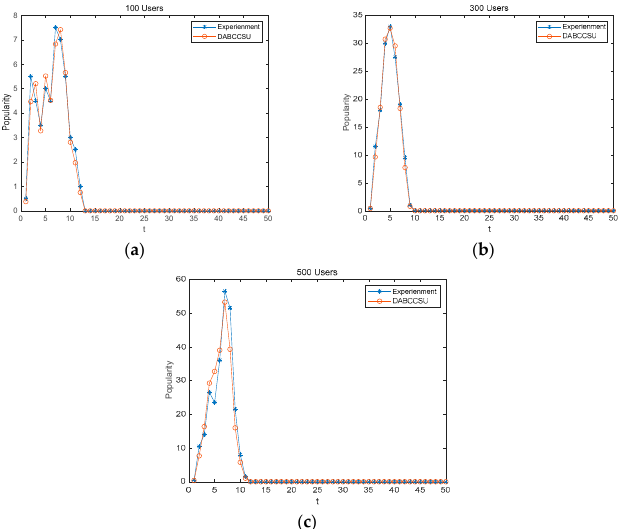
Figure 4. Prediction results of content popularity by DABCCSU: ( a ) 100, ( b ) 300, and ( c ) 500 users.